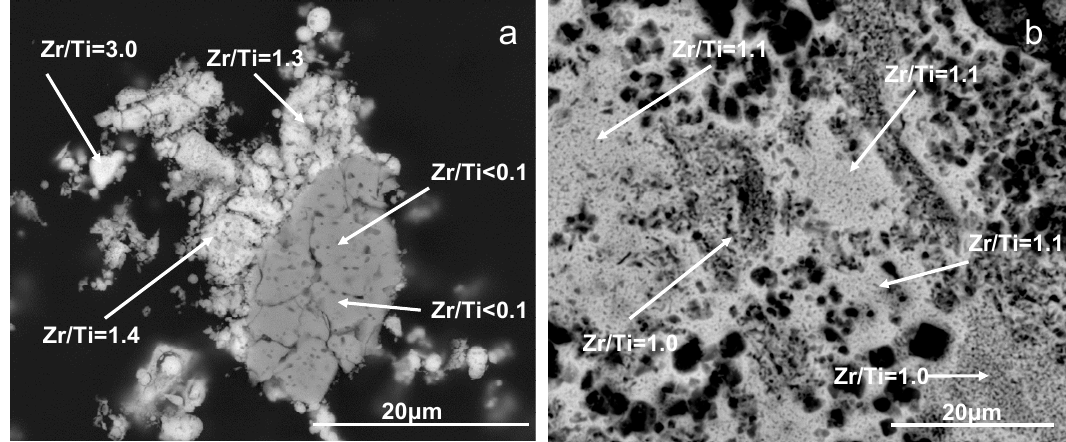
Figure 9. Scanning electron microscope (SEM)/Backscattered electrons (BSE) images of ( a ) Ti, Zr-0.6-500 and ( b ) Ti, Zr-1.2-500 samples. The Zr/Ti values found with EDS analysis for different areas of the samples are marked. Polished specimens of materials embedded in epoxy resin have been used for